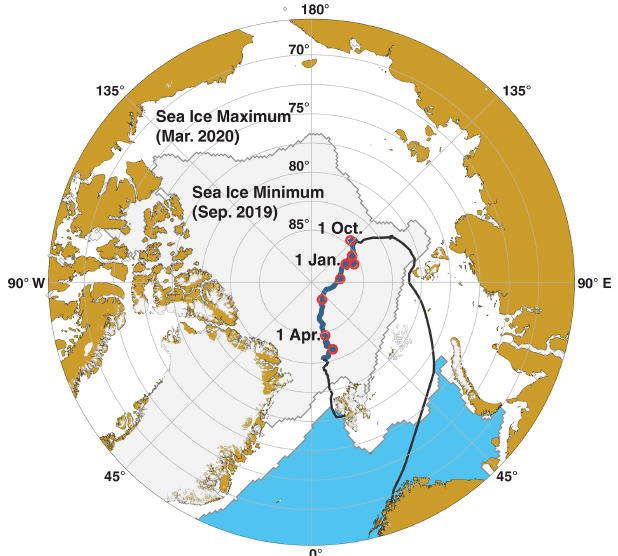
Figure 7. Travel (black) and drifting (blue) route of RV Polarstern from 1 October 2019 to 1 May 2020. The beginning of the next month is indicated by a red circle. The map was produced with ggOceanMaps package in R (Vihtakari, 2021) by using Sea Ice In- dex, Version 3, data (Fetterer et al., 2020).